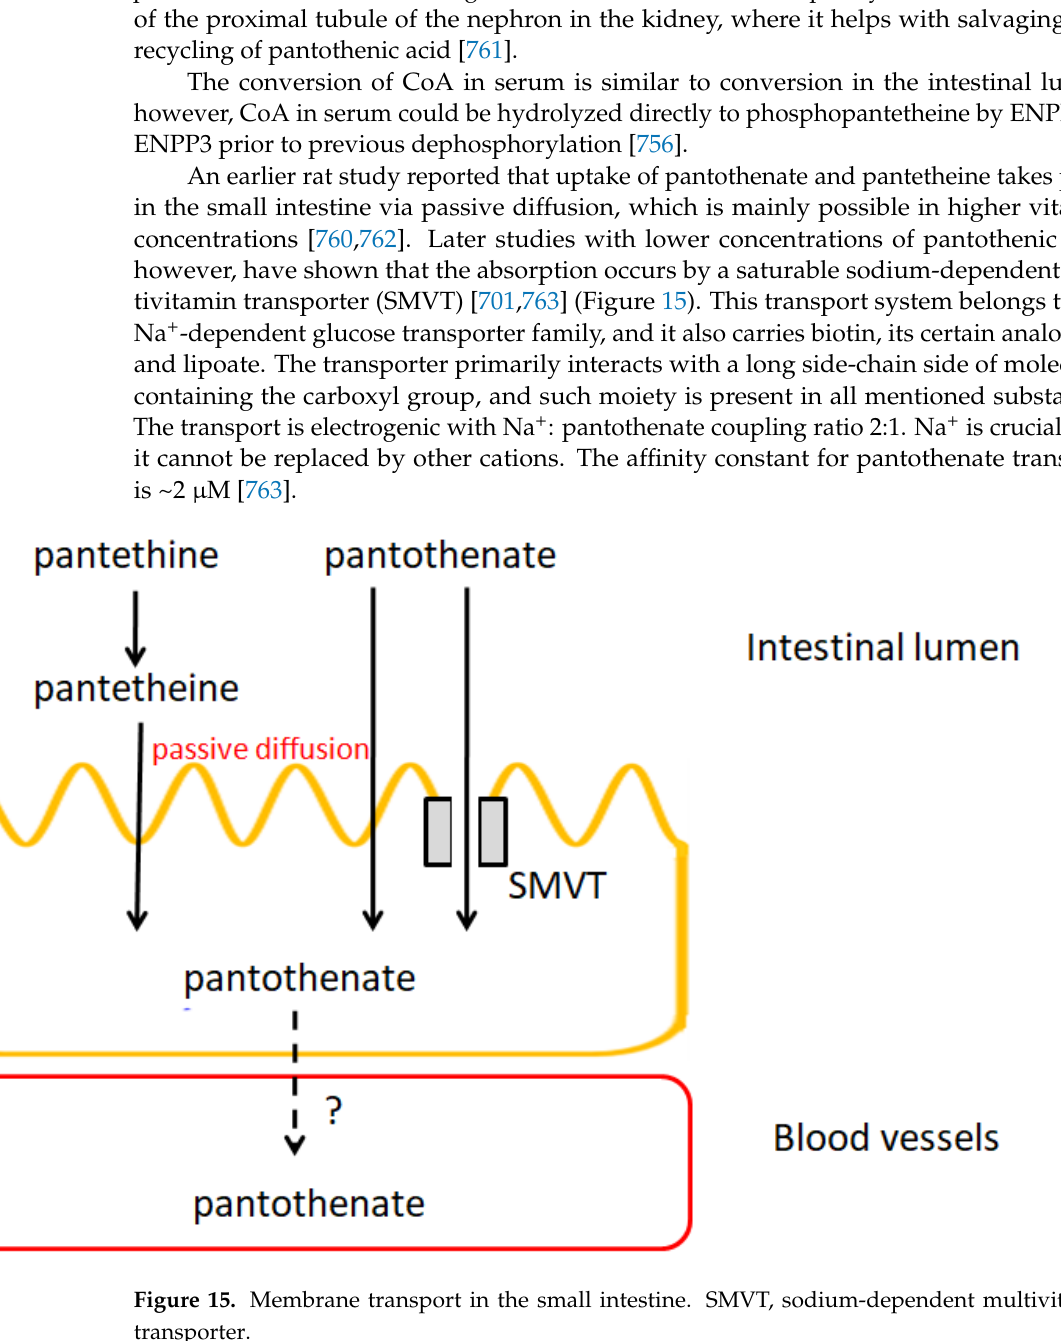
Figure 15. Membrane transport in the small intestine. SMVT, sodium-dependent multivitamin transporter.